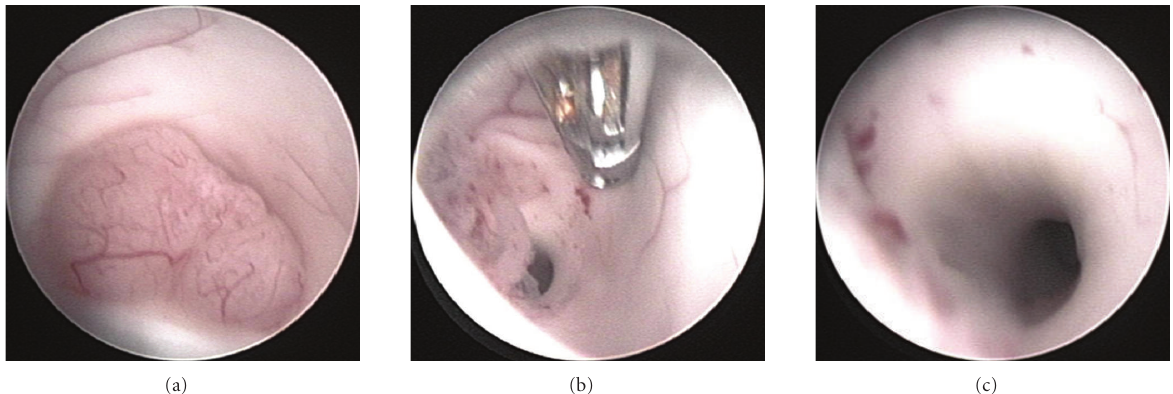
Figure 3: Intraoperative endoscopic images of the tumor at the entrance of the aqueduct before (a), within (b), and after tumor resection